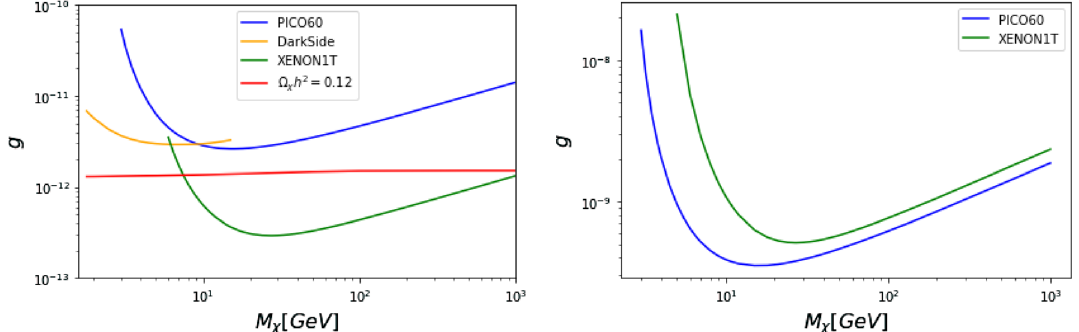
Fig. 10 Limits on the Z’ coupling, g = g f g χ , from DarkSide-50, PICO-60, and XENON1T, for the Z’ model with pure vector couplings (left) and from PICO-60 and XENON1T for pure axial-vector couplings (right) for a light mediator, M (cid:2)